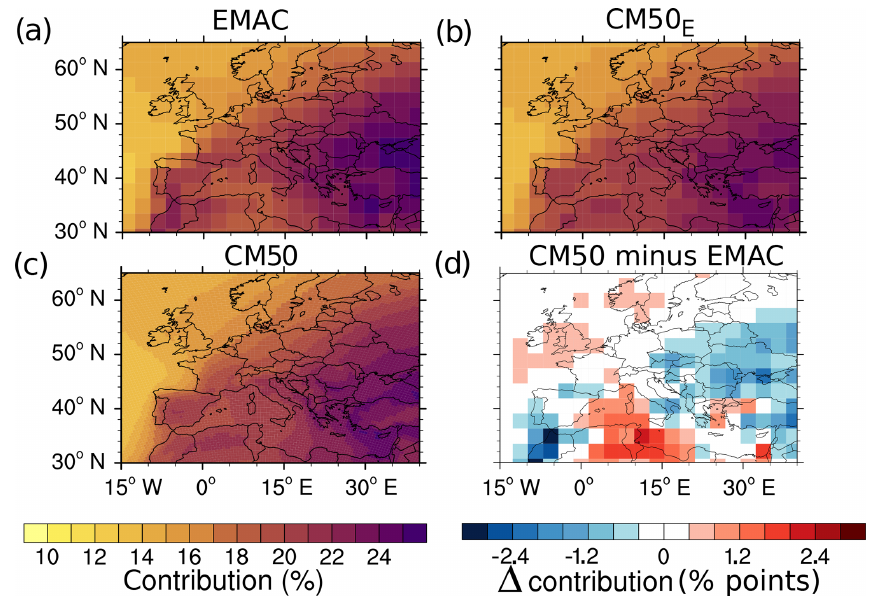
Figure 10. Comparison of the JJA average ground-level contribution (in percent) of O soi (a) results of EMAC, (b) results of CM50 transformed onto the EMAC grid, (c) results of CM50 on the original grid, and (d) difference (“CM50 minus EMAC” in percentage points) on the coarse grid. Comparisons in (a–c) use the same scale. Shown are the results of the REF simulation, averaged over